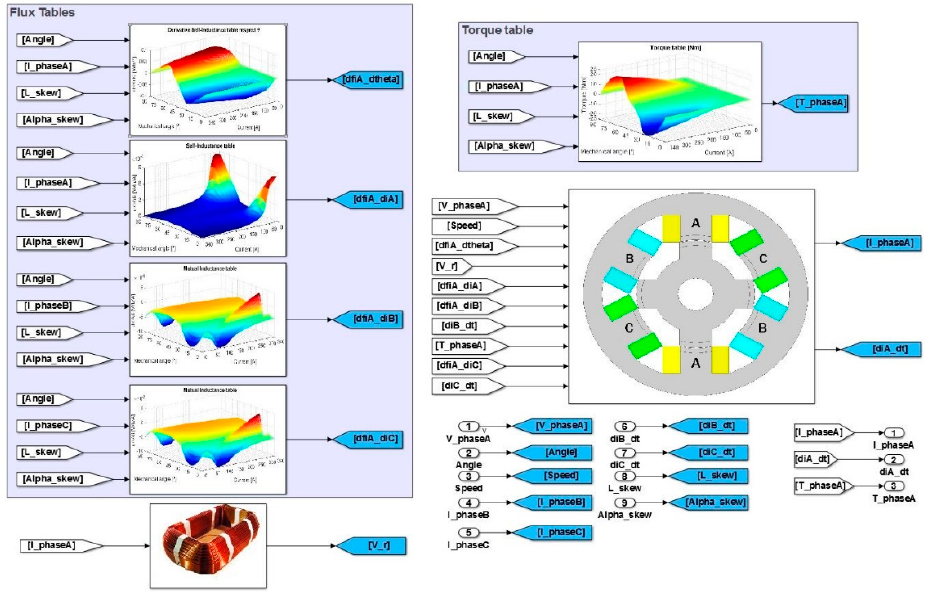
Figure 12. MATLAB-Simulink ASR-SRM model.